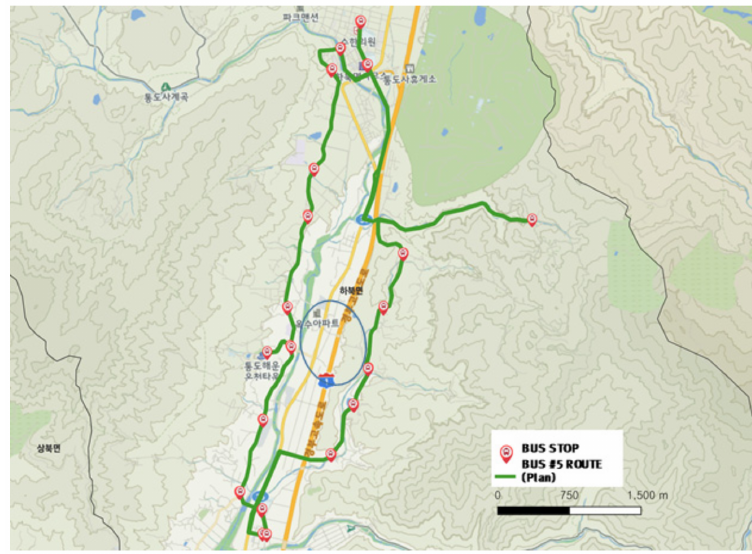
Figure 17. City-type bus No. 5 (general)